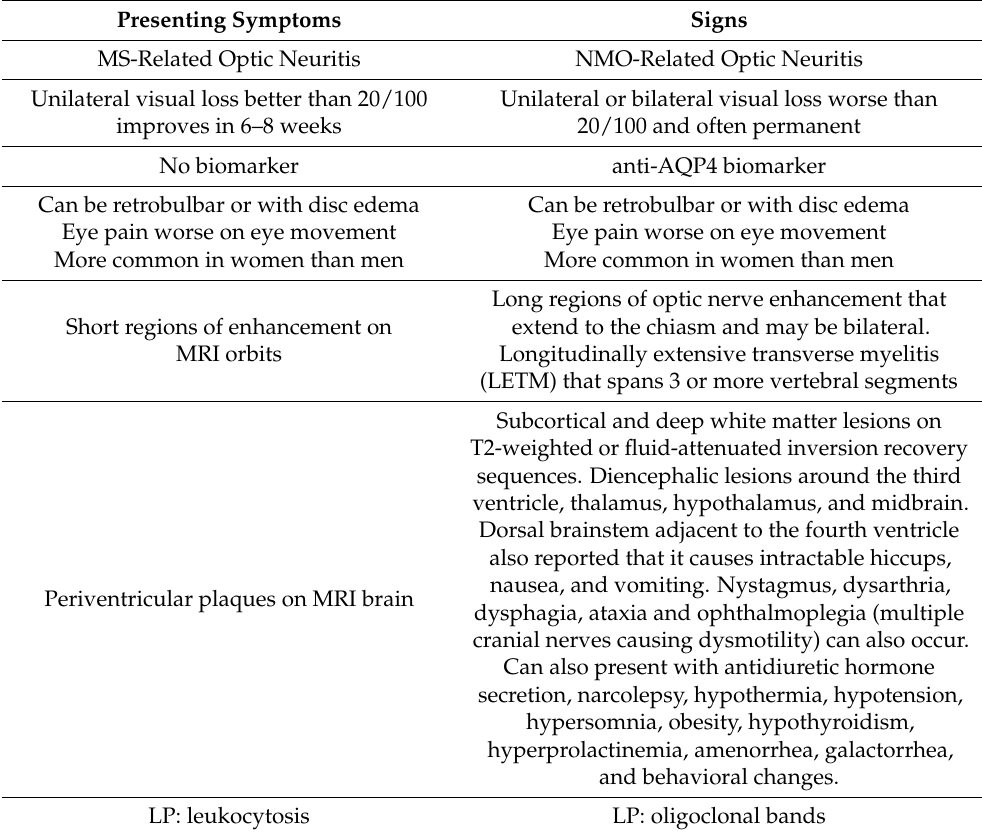
Table 6. Signs and symptoms differentiating Multiple Sclerosis Optic Neuritis and NMO-related Optic Neuritis